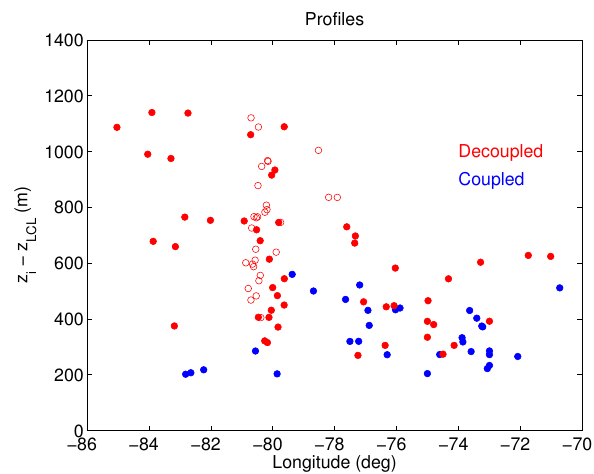
Fig. 8. Decoupling, mixed layer cloud thickness 1z M , and driz- zle by longitude for each subcloud leg. Blue (red) markers indicate well-mixed (decoupled) legs. Moderately drizzling legs are indi- cated by triangles, lightly drizzling legs by circles, and nondrizzling legs by squares. POC legs are indicated by hollow markers.